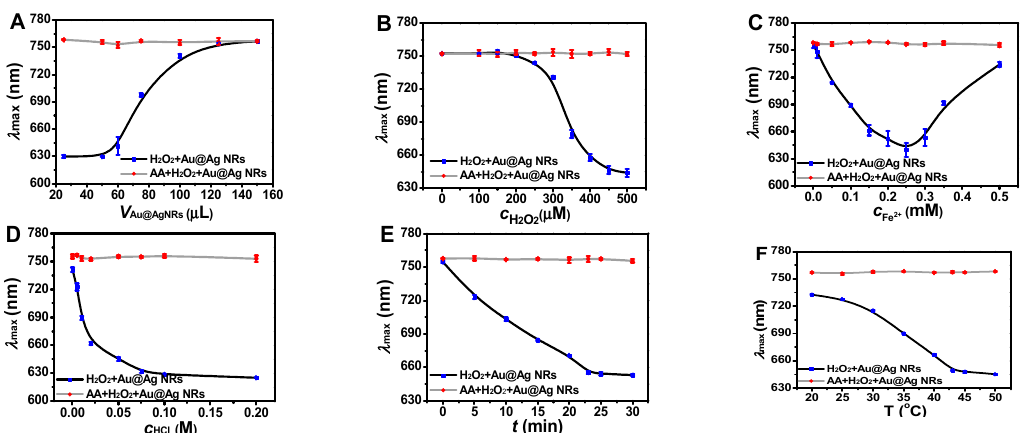
could enable the full restoration of λ max .